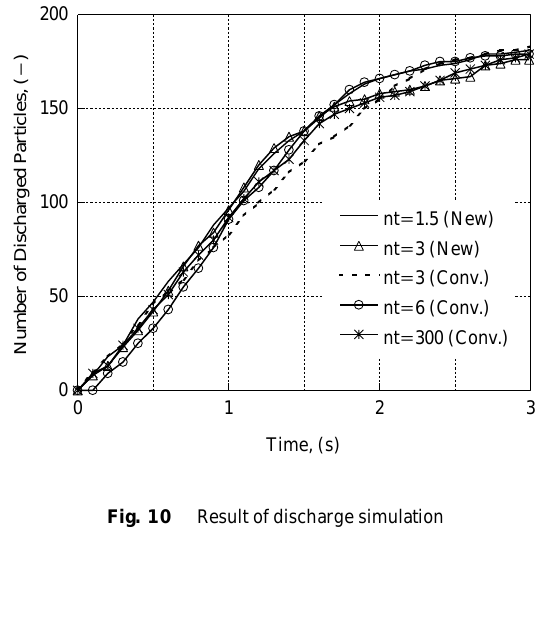
Result of discharge